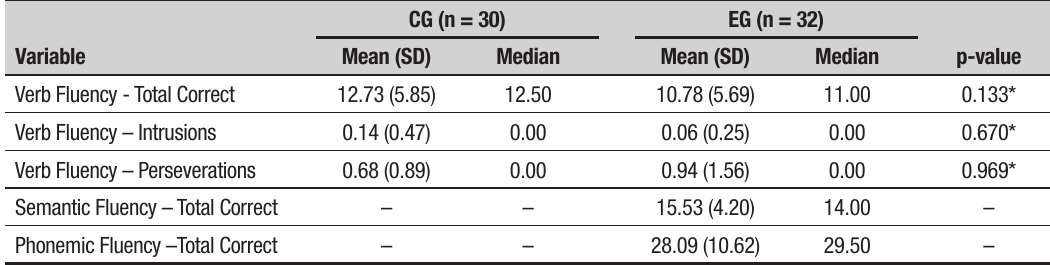
Phonemic Fluency –Total